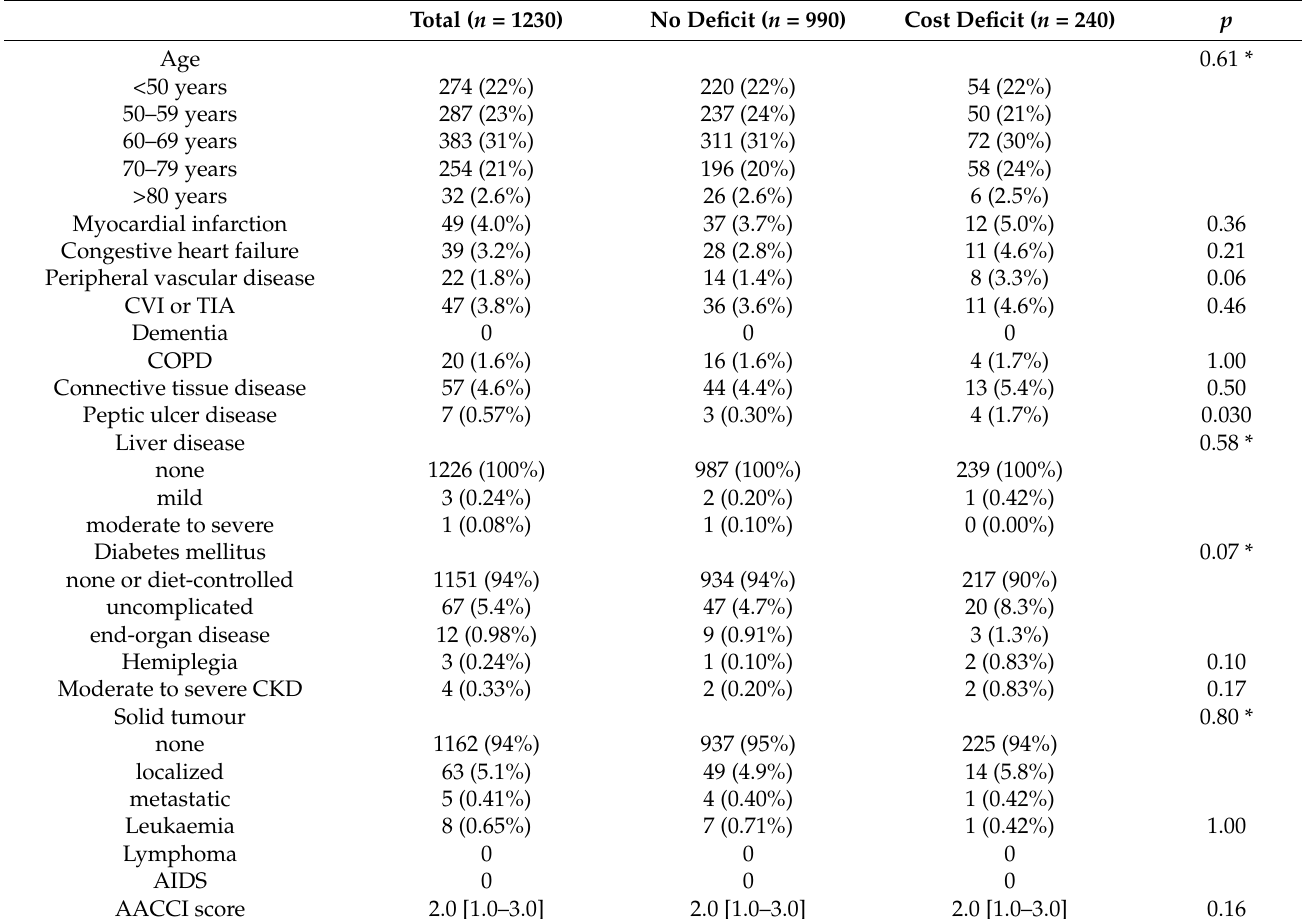
Table 2. Age-adjusted Charlston Comorbidity Index components. AACCI components are listed below. p -value refers to the difference on net financial results between both groups.